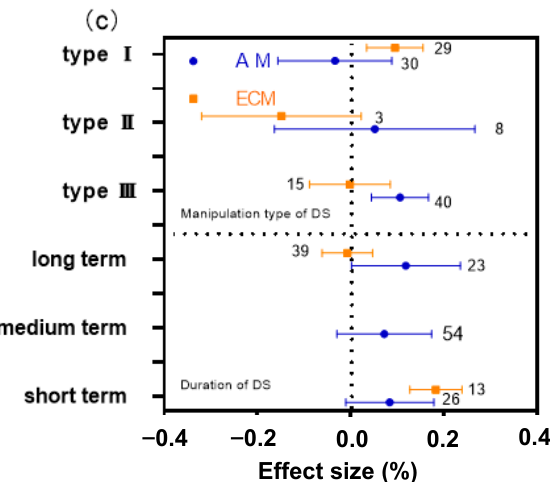
Figure 2. The mean effects of drought on arbuscular mycorrhizal N ( a ), P ( b ), and N:P ratio ( c ) and ectomycorrhizal N ( a ), P ( b ), and N:P ratio ( c ) were classified according to the type and duration of drought stress (DS). Type I, constant-stressed type; type II, drying and rewetting cycle type; type III, intermittent drying type. Short term, <30 d; medium term, 31 to 90 days; long term, >90 days. The error bar represents a 95% bootstrap confidence interval (CI). If the 95% CI of effect size did not overlap with zero, drought stress was considered to be the effect. The number of observations for each category is shown next to the error bar.